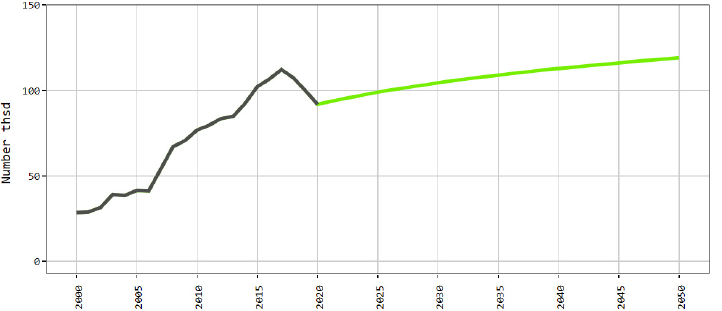
Figure 14. Number of sheep in Latvia in 2000–2020, with a projection for 2021–2050, thousands [62].